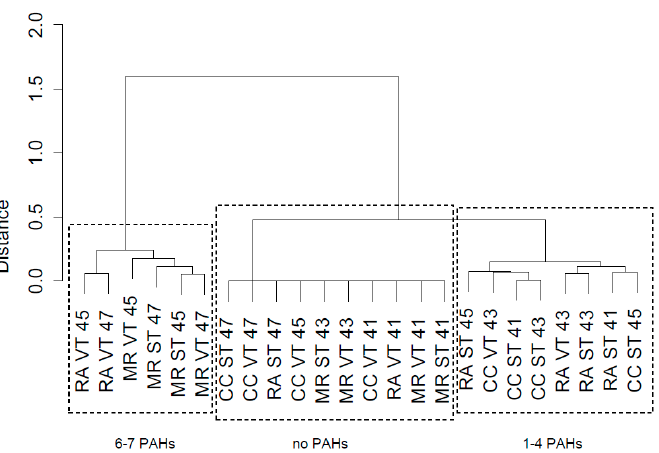
Figure 3. Hierarchical clustering of 24 samples of leaf litter from urban street trees based on their PAH concentration by referring to Euclidean distance. CC, city center; MR, main road; RA, residential area; VT, vacuum technique; ST, suction technique. Numbers indicate calendar weeks during which the sample was